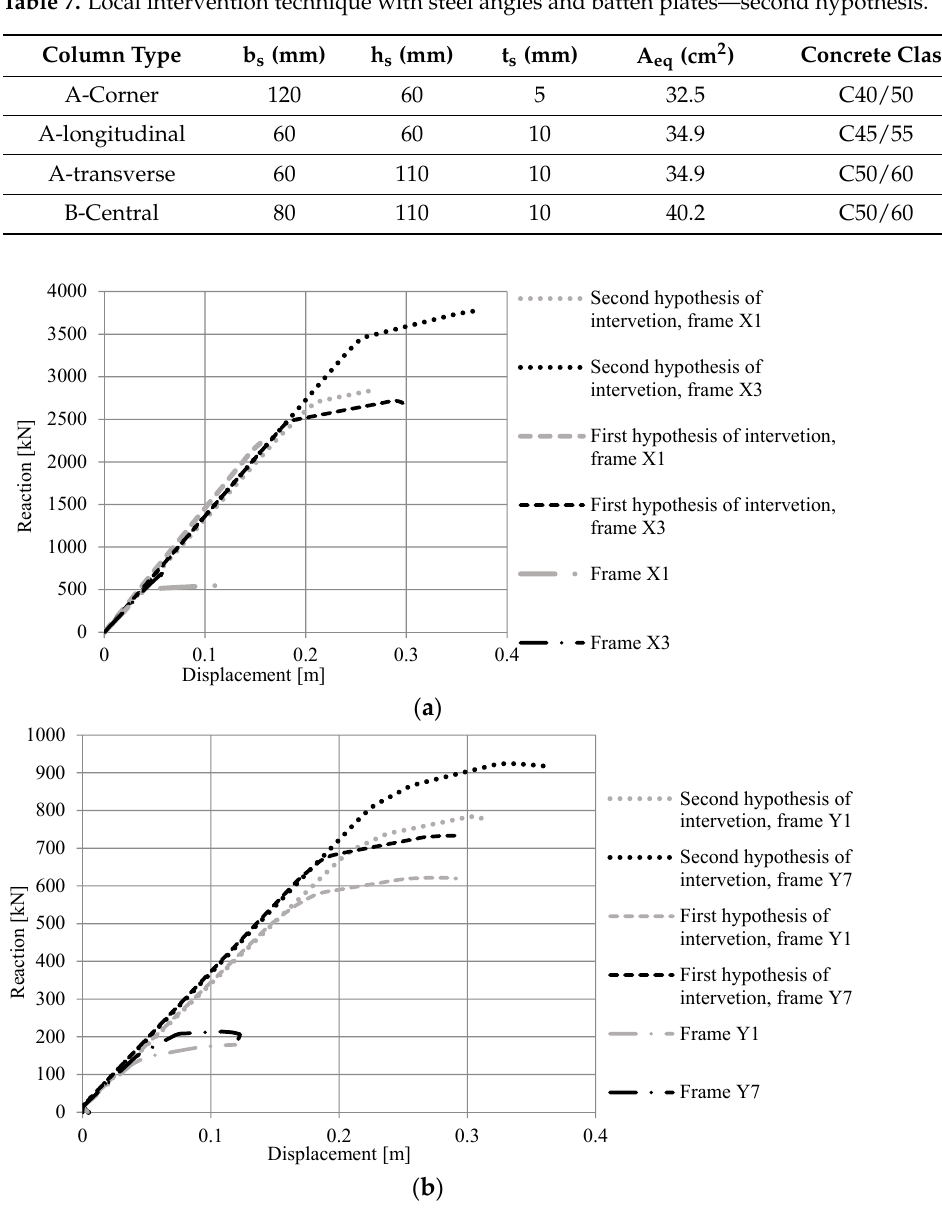
Figure 24. Comparison of pushover curves before and after both local intervention hypotheses in the X -direction ( a ) and the Y -direction ( b ).